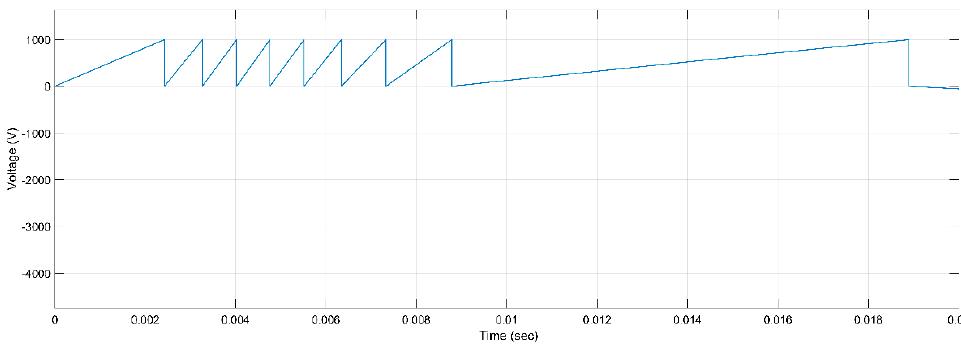
Figure 31. PD Activity for Combination, 15 kV, 2 h, r.